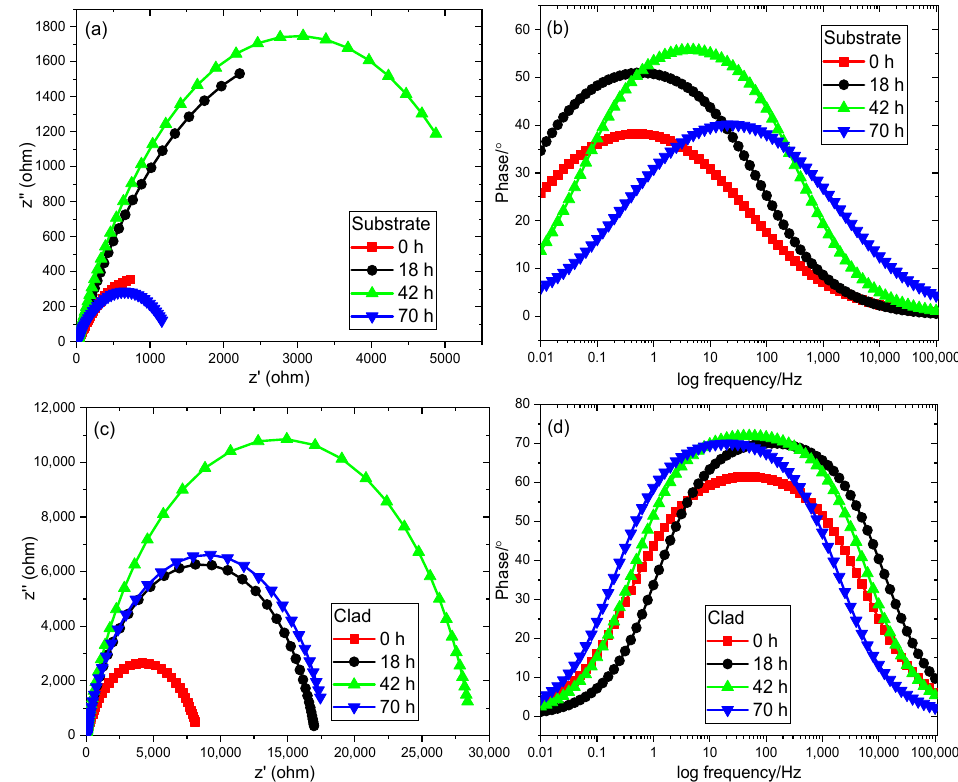
Figure 10. Nyquist and bode plots obtained from EIS analysis for different time treated ( a , b ) 316L substrate samples, and ( c , d ) Cladded samples. Table 5. The elemental compositions of both substrate and clad samples at different time intervals.